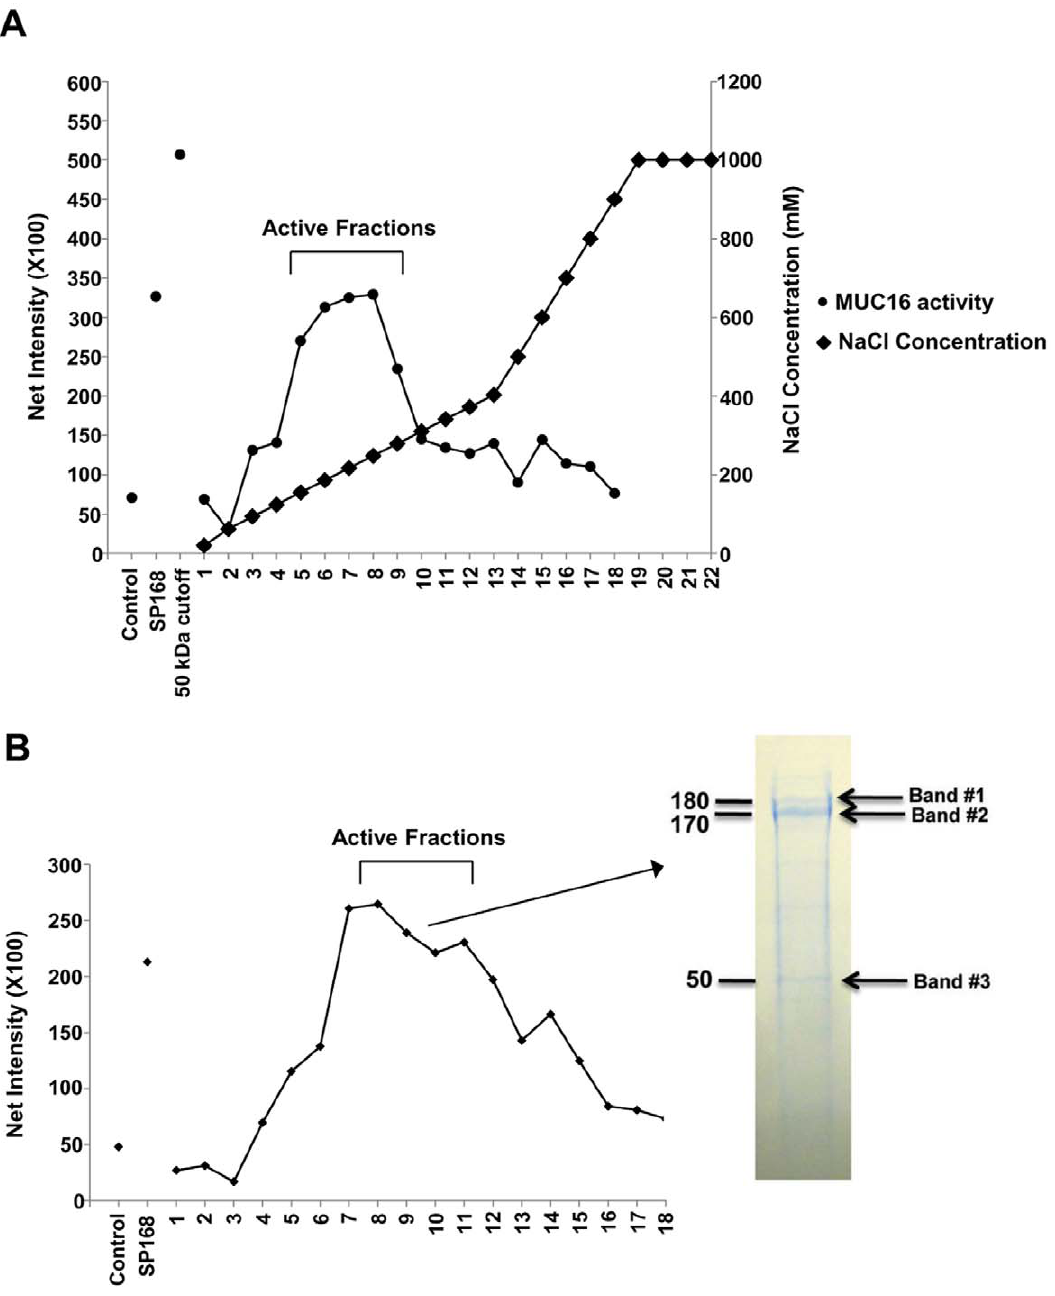
Figure 4. Isolation of the MUC16 sheddase and its identification as ZmpC. MUC16 sheddase-enriched fractions were isolated first by DEAE chromatography, with concentrations of sodium chloride eluent shown in the figure on the right ( A ), then by size exclusion chromatography ( B ). A sample from fraction 9 (indicated by an arrow) in B was separated by SDS-PAGE and stained using GelCode Blue stain. The 3 bands observed at , 180 kDa, , 170 kDa and , 50 kDa were analyzed by mass spectrometry. Numbers on the left of the gel indicate molecular weight standards in kDa. The Y axes of graphs in (A) and (B) represent the net intensities corresponding to MUC16 signal on western blots. Constitutive MUC16 ectodomain release was observed in fractions whose net intensities correspond to that of the control. The mechanism(s) associated with constitutive MUC16 ectodomain shedding remains unknown. doi:10.1371/journal.pone.0032418.g004 (Figure 8). These data indicate that SP168 can more efficiently Discussion invade corneal epithelial cells as a result of exposure to the In order for disease-causing, non opportunistic bacteria, to bacteria. Since cell invasion is a well-established process of infect mucosal tissues, they must cross the MAM glycocalyx infection, these experiments indicate that a loss in the levels of barrier that normally prevents adherence of opportunistic bacteria apical MUC16 on the epithelial barrier enhances internaliza- tion, thus infection. to epithelial surfaces [3,11,12]. Data provided herein describe for